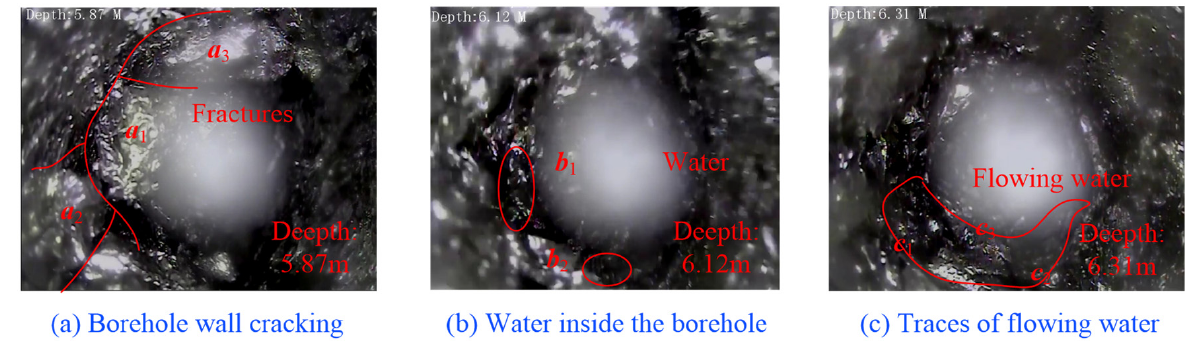
Figure 2. Borehole view of borehole deformation and damage after groundwater